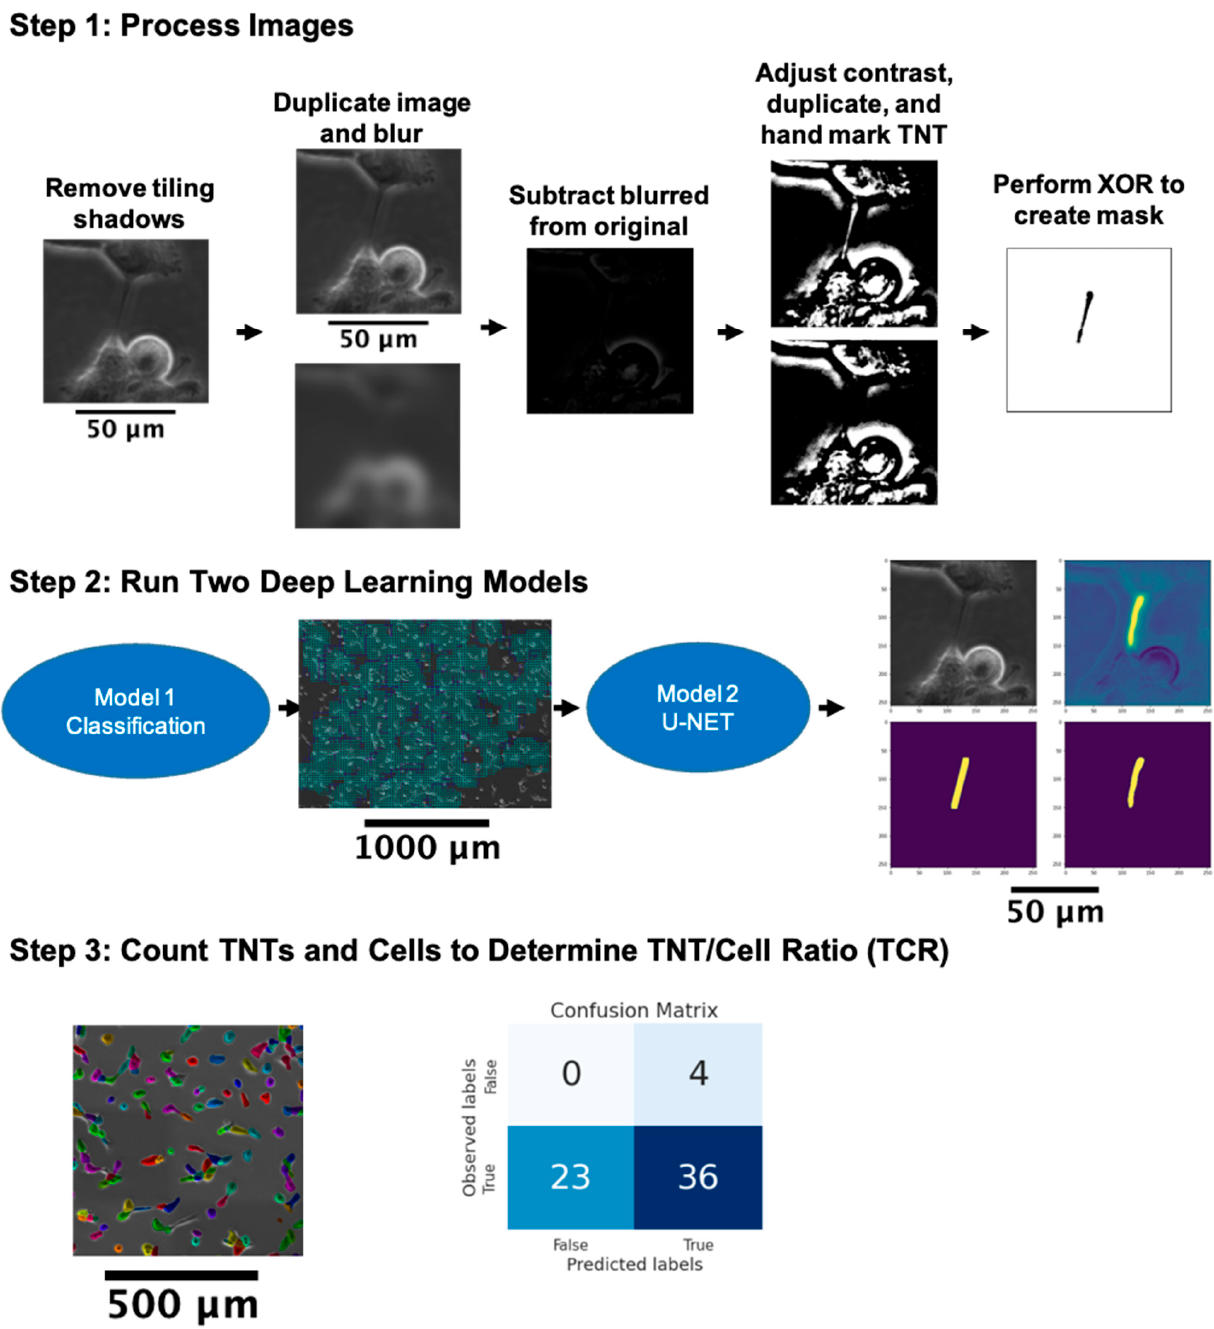
Figure 3. Flow diagram of AI-based TNT detection. Images were (Step 1) pre-processed for label correction and (Step 2) subdivided into a matrix of smaller image regions (‘patches’) that were classified as either containing or not containing any TNT structures, and pixel-wise classified regarding whether each pixel belonged to a TNT structure or not (see Supplementary Figures S1 and S2 and Supplementary Table S2). In (Step 3), the numbers of TNTs and cells were counted, and the TNT-to- cell ratio (TCR) was calculated (each colored object is an individual cell) and confusion matrix was reported (see Table 2 and Supplementary Table S3). XOR = bitwise exclusive or